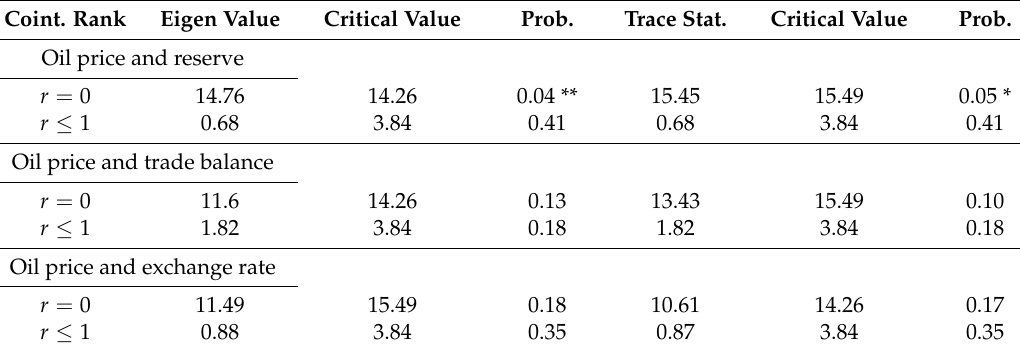
Table 6. Johansen unrestricted bivariate cointegration